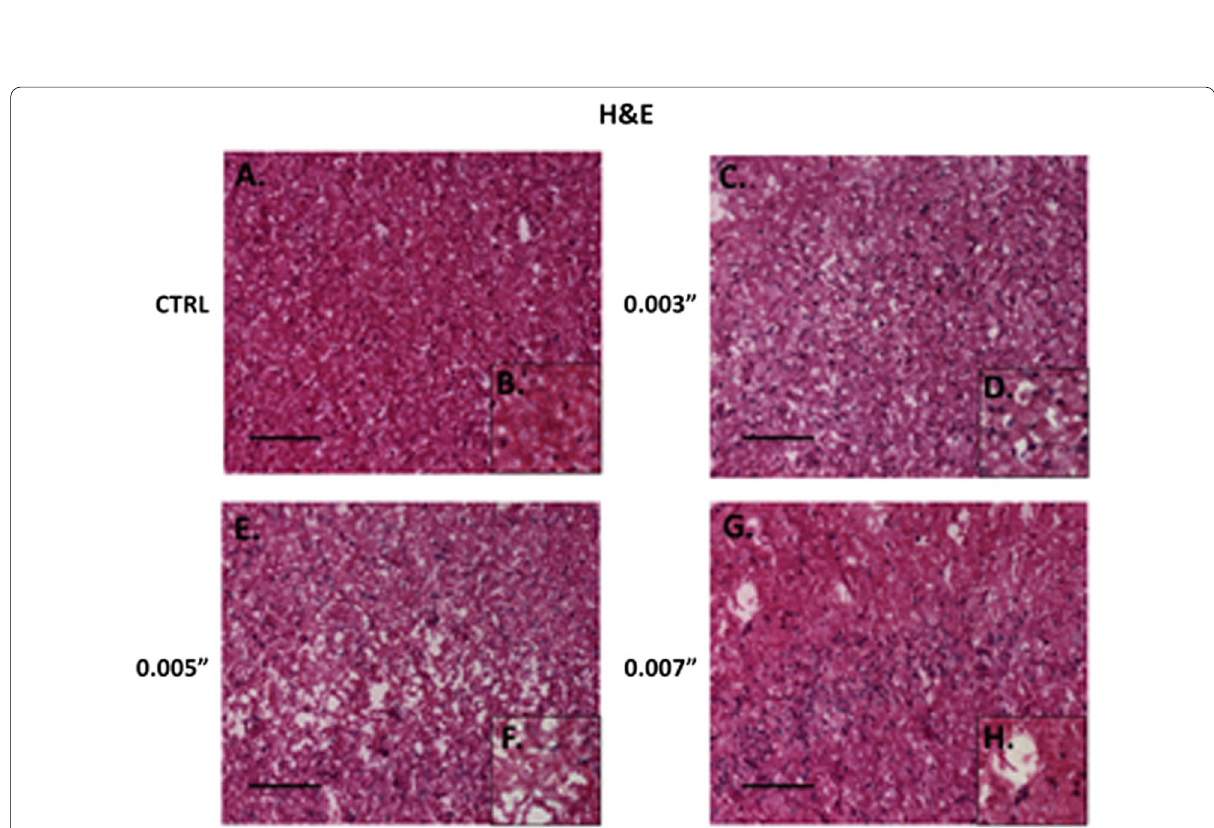
Fig. 2 TBI severity is associated with increased neuronal damage. Increased chromatolysis and red (dead) neurons are seen with graduated increase of severity of TBI from mild to severe. a Control group 40x magnification. b Control group 63x magnification. c Mild TBI 40x magnification. d Mild TBI 63x magnification. e Moderate TBI 40x magnification. f Moderate TBI 63x magnification. g Severe TBI 40x magnification. h Severe TBI 63x